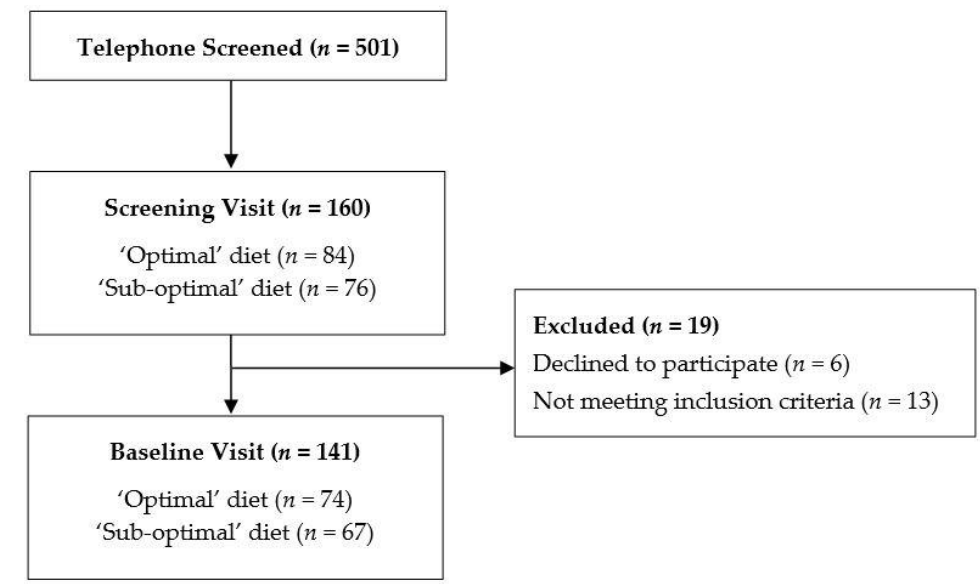
Figure 1. Flowchart of participants included in the study.